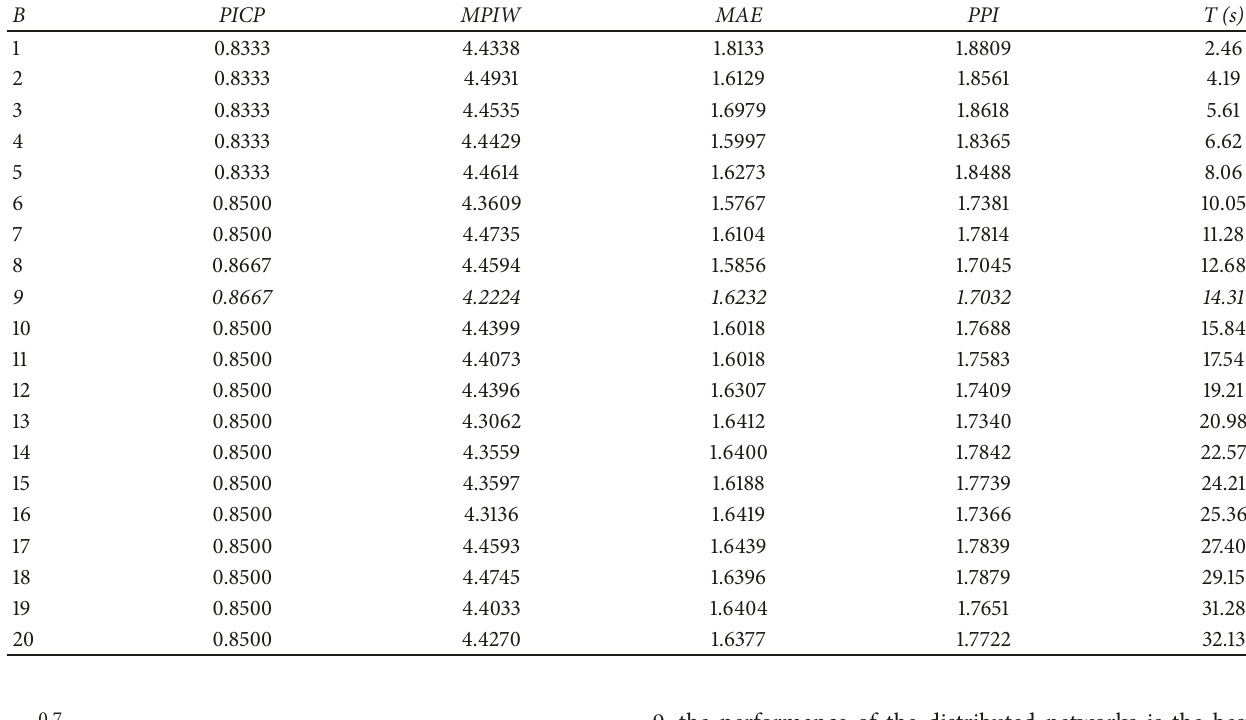
Table 4: The validation result of the number of local networks.